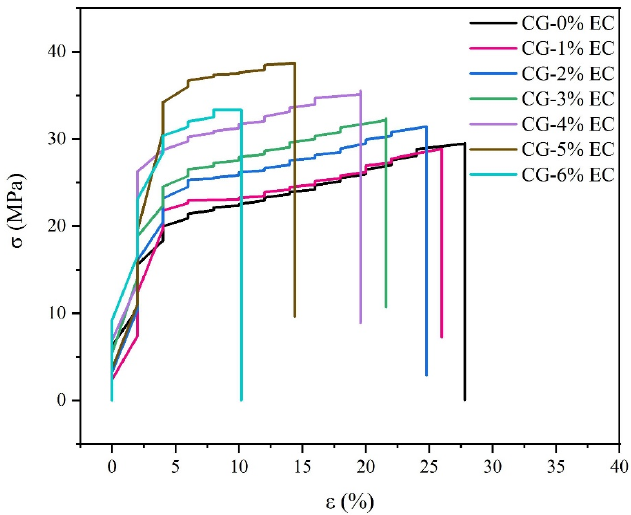
Figure 4. The stress–strain curves of films incorporated with different amounts of EC.